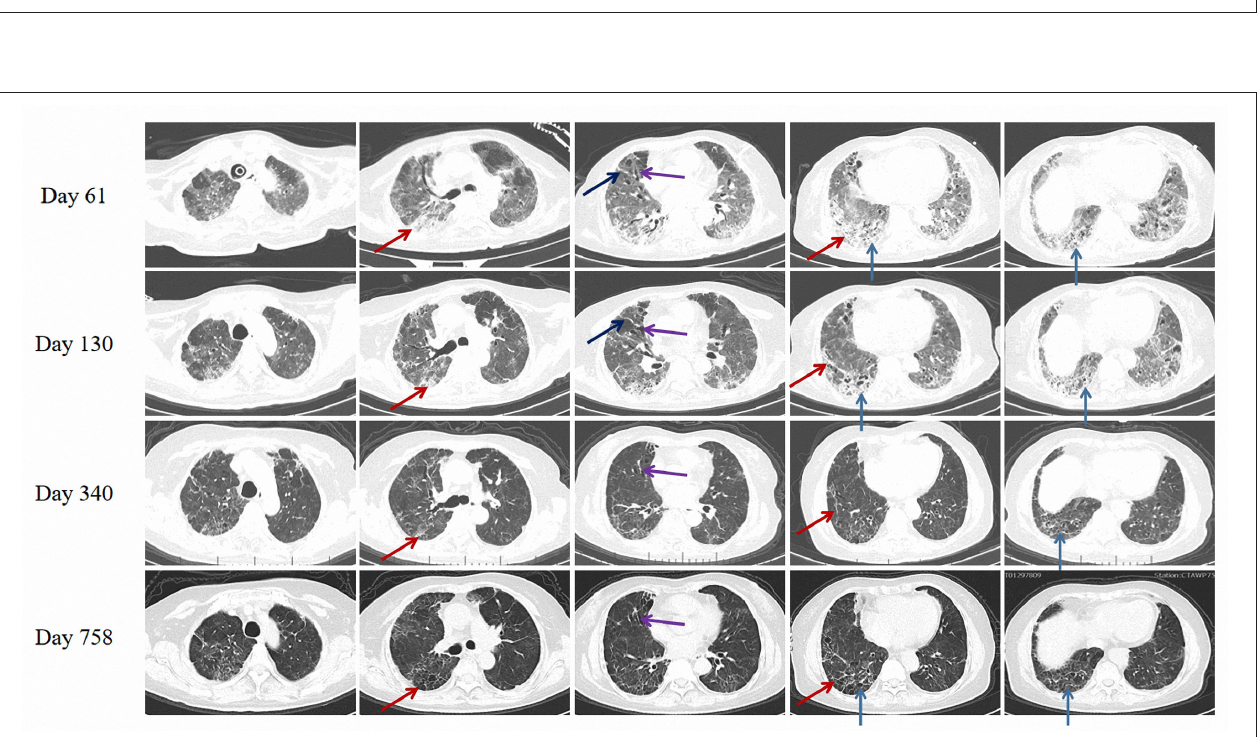
FIGURE 1 | Chest CT of the patient on day 2 and day 3 (On admission) after illness onset. Red dotted arrow: multiple ground glass opacities (GGOs); Black dotted arrow: consolidation.